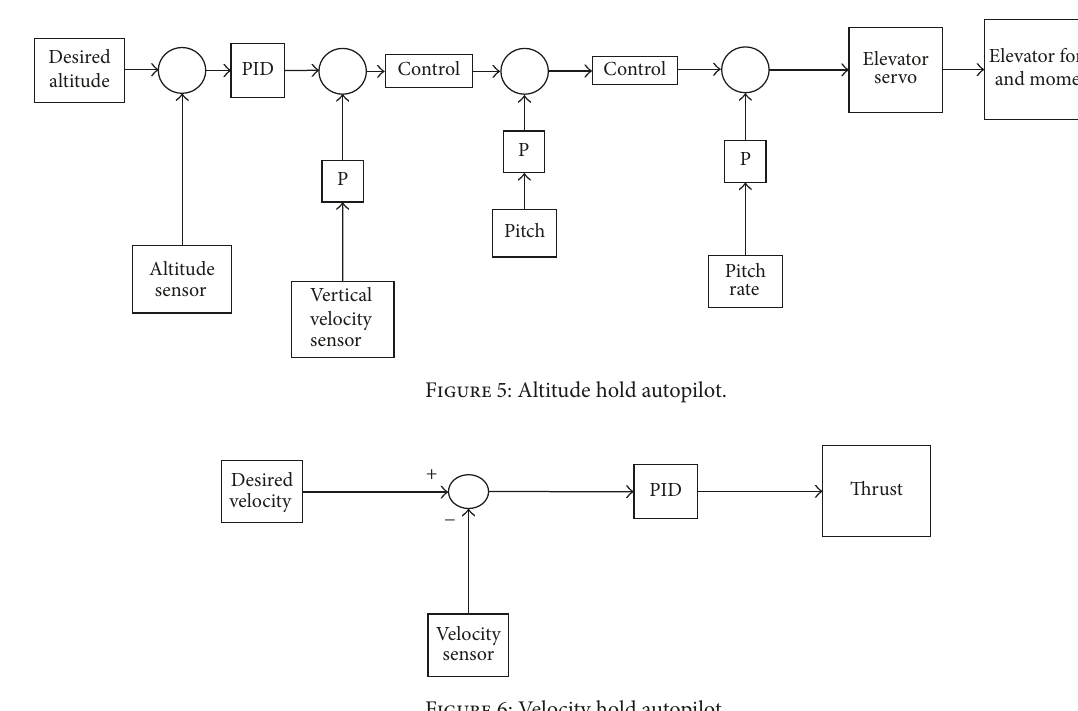
Figure 6: Velocity hold